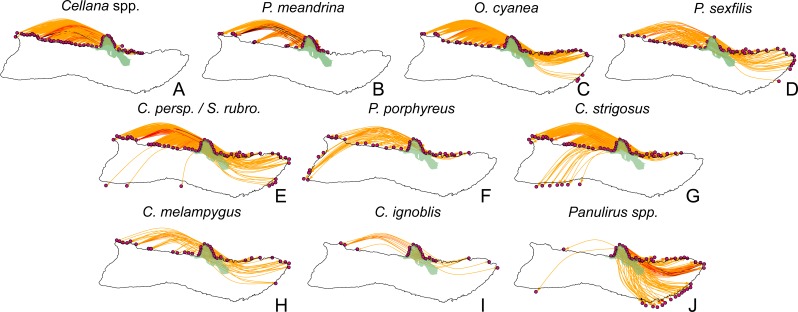
Larval spillover from Kalaupapa National Historical Park.Site-level dispersal to sites around Moloka‘i from sites in the Kalaupapa National Historical Park protected area, by species. (A–D) Short dispersers (3–25 days), (E–G) medium dispersers (30–50 days), and (H–J) long dispersers (140–270 days). Edge color reflects proportion of dispersal along that edge; red indicates higher proportion while yellow indicates lower proportion. Kalaupapa National Historical Park is highlighted in light green.